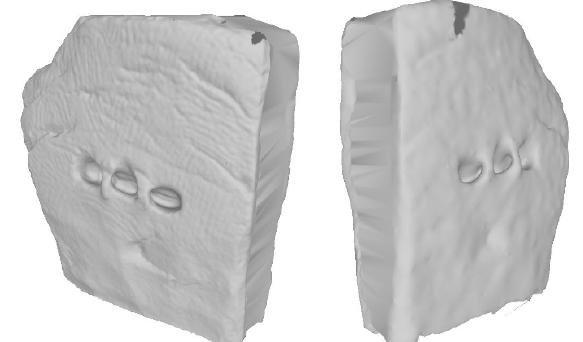
Figure 5. Reconstructed monolith: the high resolution scanned face (left) and the decimated reconstructed face (right) Other documents are integrated indirectly. The data they contain are stored in the BIM elements through parameters, but the used are built-in or created especially for the need of the